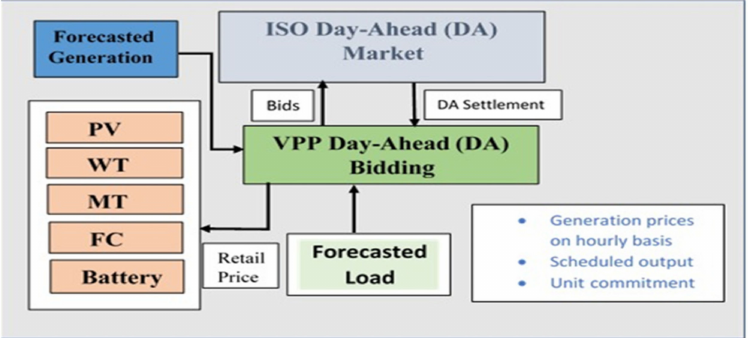
Figure 2. Day-ahead market strategy of the VPP.